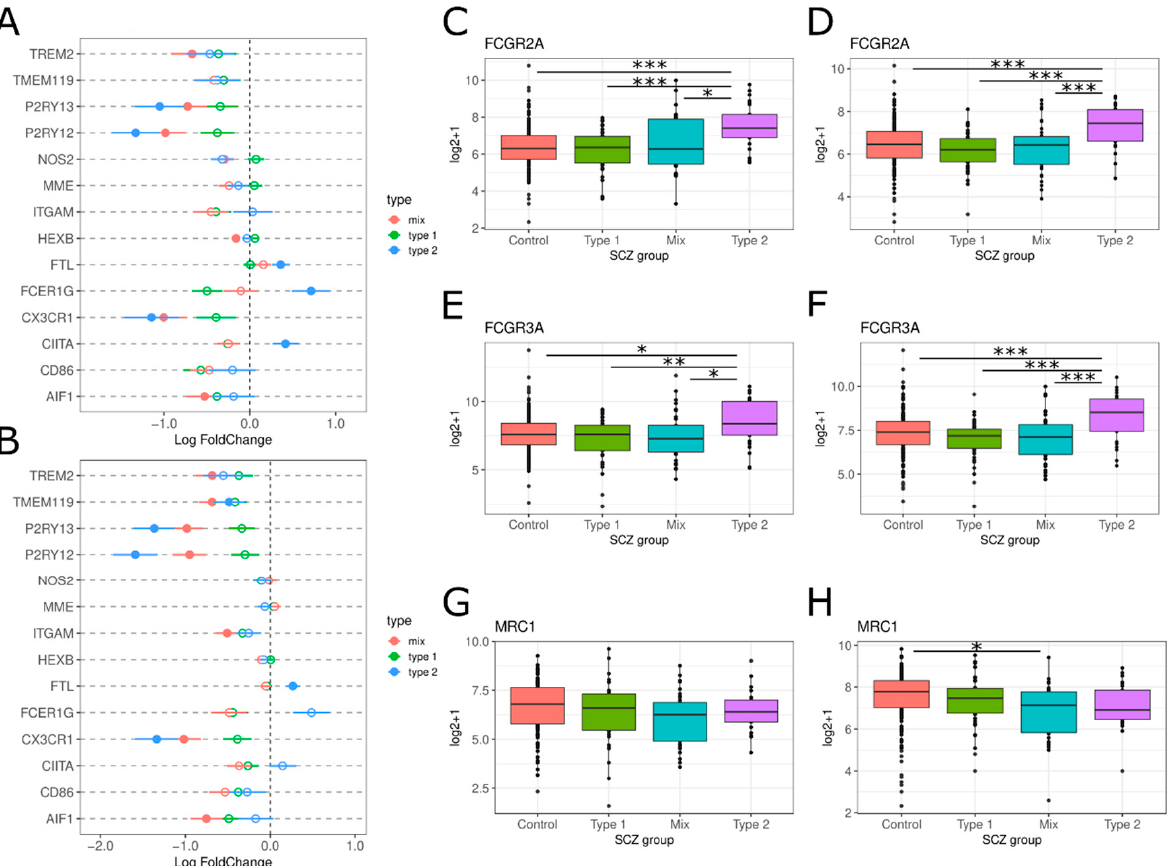
Figure 5. Microglia marker expression in the SCZ groups. ( A , B ) LogFC for genes associated with microglial activation across SCZ subtypes: Type 2 (blue), Mix (red), Type 1 (green). Lines indicate standard error. Filled circles = differentially expressed (Benjamini-Hochberg p -value < 0.05), empty circles = not differentially expressed. ( C – H ) Boxplot of the log2+1 expression data is shown for each SCZ group: Controls (red), Type 1 (green), Mix (blue) and Type 2 (purple). Graphs on the left are polyA and graphs on the right are riboZ. * p -value < 0.05, ** p -value < 0.01, *** p -value < 0.001 via Tukey